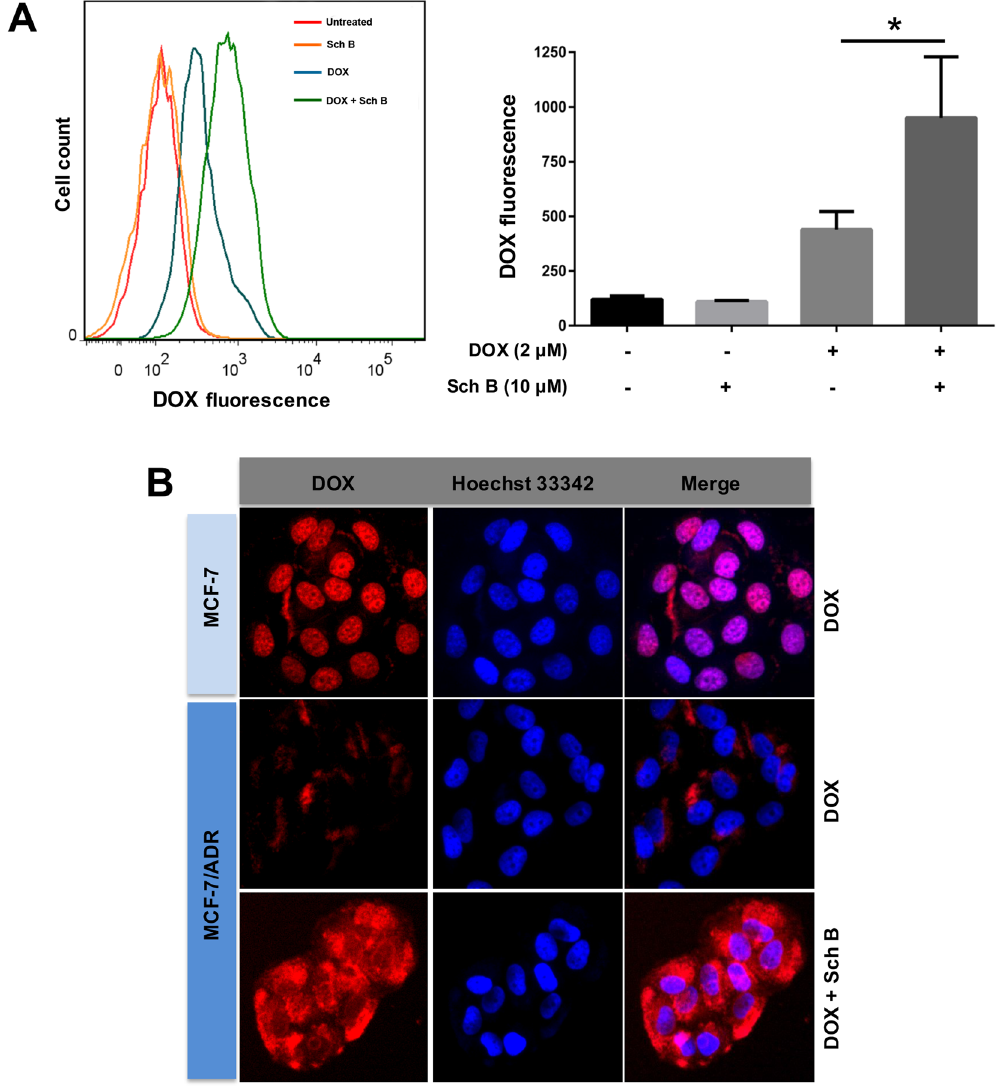
Figure 3. Sch B increases the intracellular accumulation of DOX. MCF-7 and MCF-7/ADR cells were pretreated with Sch B for 12 h and then incubated with 2 µ M of DOX for 4 h. The intracellular level of DOX was determined by flow cytometry ( A ) and observed using Incell Analyzer 2000 (GE Healthcare) ( B ). * P <